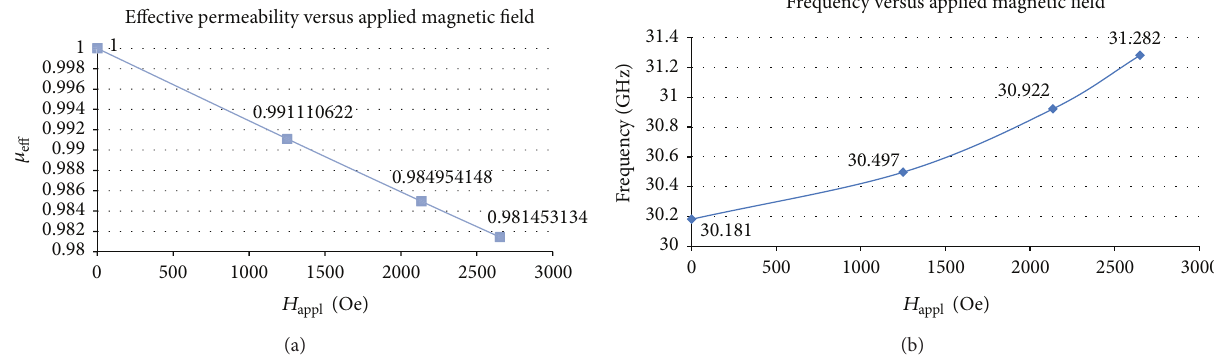
Figure 5: (a) Computed variation of the effective permeability 𝜇 applied magnetic field from 𝐻